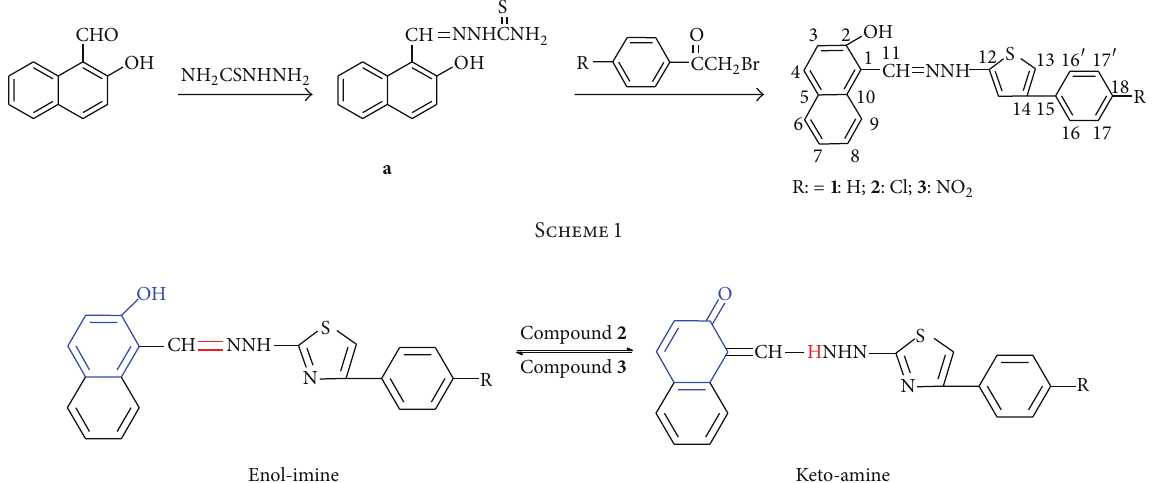
Scheme 2: Tautomerism of aromatic aldehyde